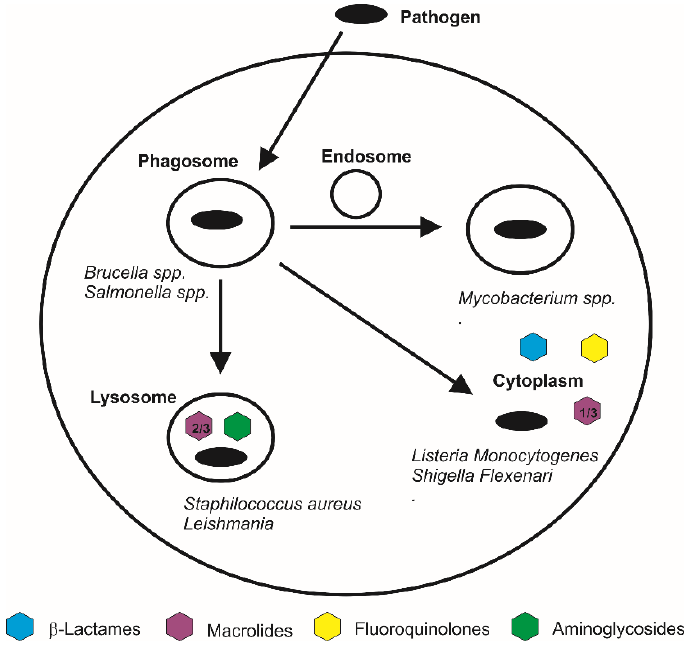
Figure 2. Scheme of the intracellular fate of several pathogens and antibiotics.